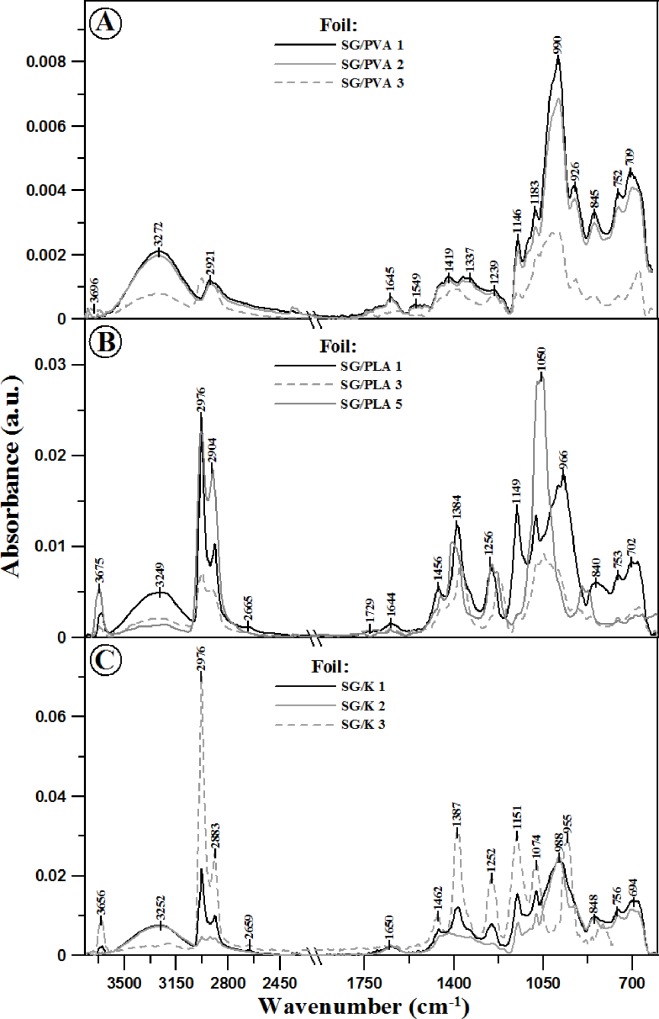
ATR-FTIR absorption spectra for the analysed foils: SG/PVA (Panel A), SG/PLA (Panel B), SG/K (Panel C).